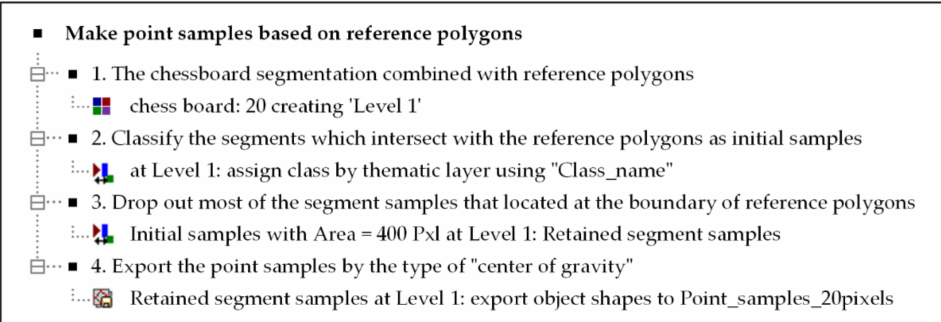
Figure 4. Algorithm for making point